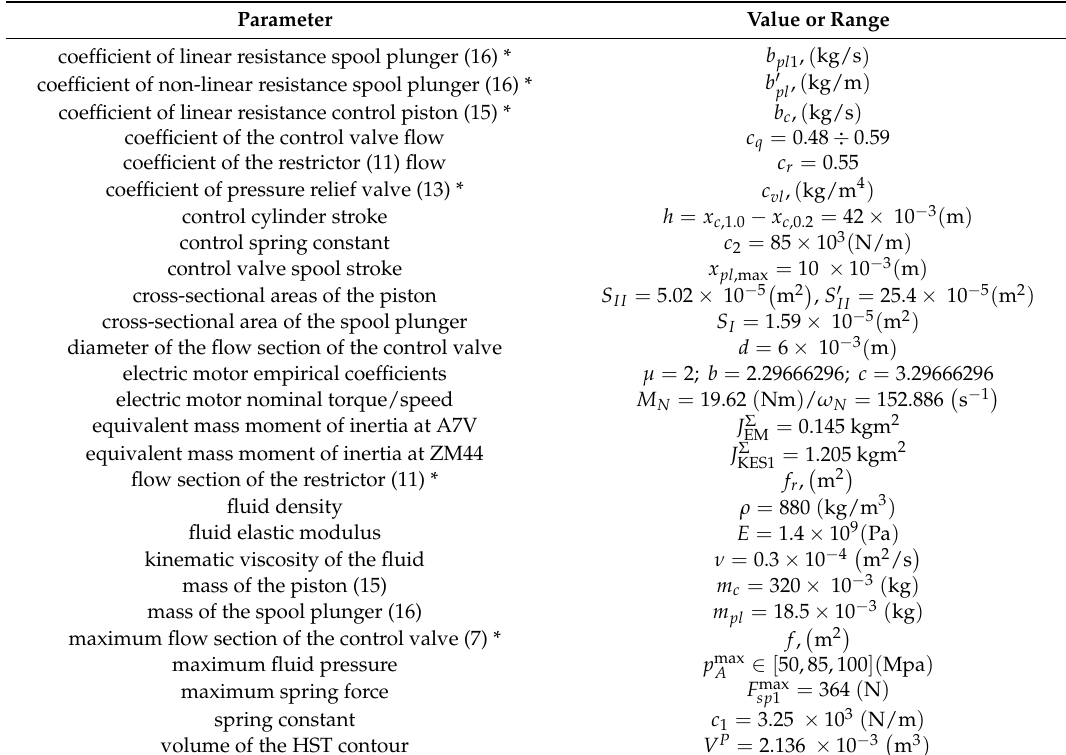
Table A2. The list of used